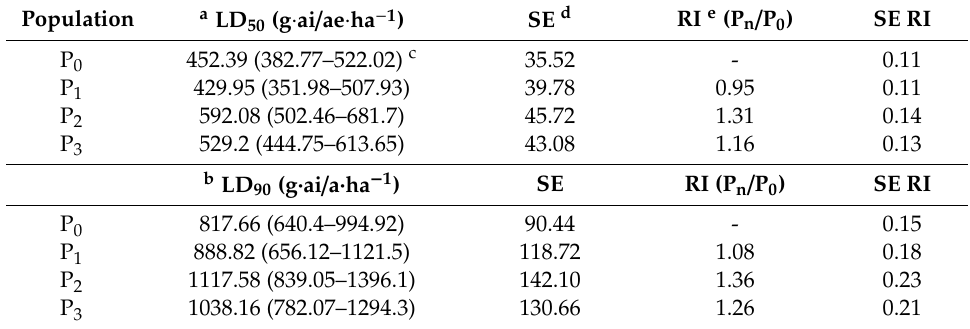
a LD b LD 50 —represents the rate that results in 50% mortality. 90 —represents the rate that results in 90% mortality. c Values in parentheses indicate 95% confidence intervals. d SE—standard error. e RI, the resistance index, is a population’s LD 50 or LD 90 divided by the value of the same parameter for the parental population, P 0 .